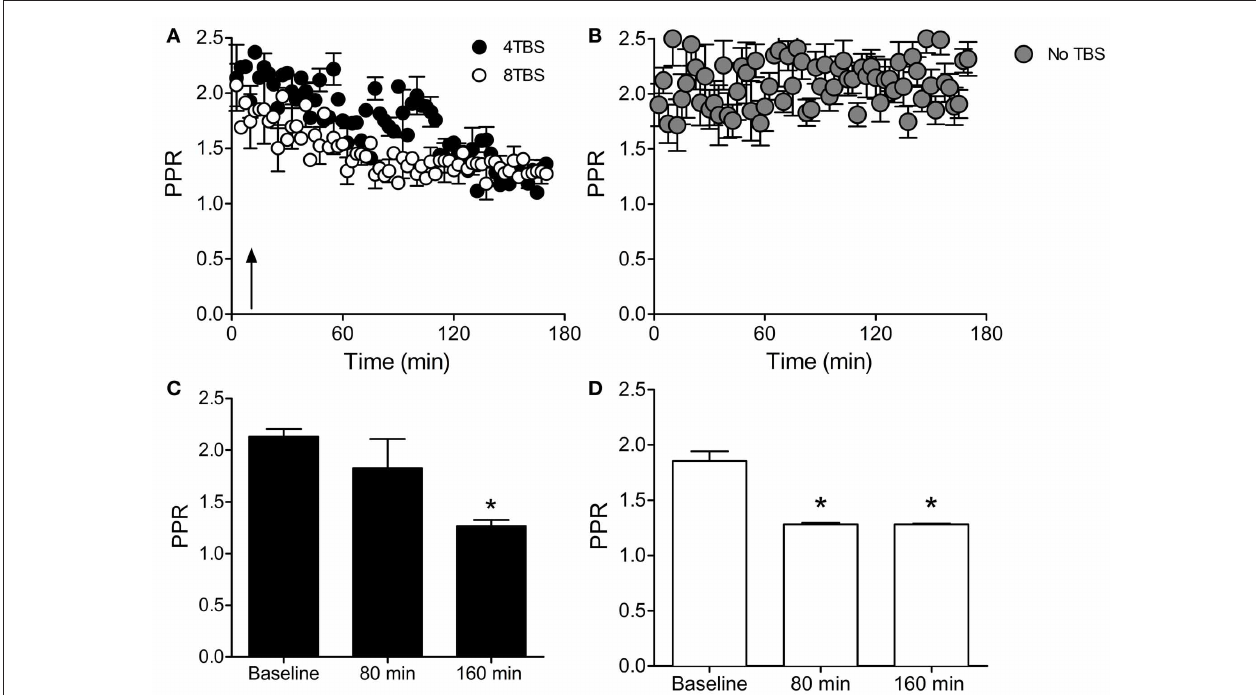
FIGURE 5 | PPRmeasurementsdemonstrateincreasedreleaseprobability with LTP2 and LTP3. (A) Paired-pulse ratio (PPR) in slices stimulated with 4TBS and 8TBS (at time point indicated by arrow) showing a reduction in the ratio over time for both groups. (B) PPR was stable in the absence of TBS. (C) Bar graph showing mean PPR during the first 10min of recording (Baseline)